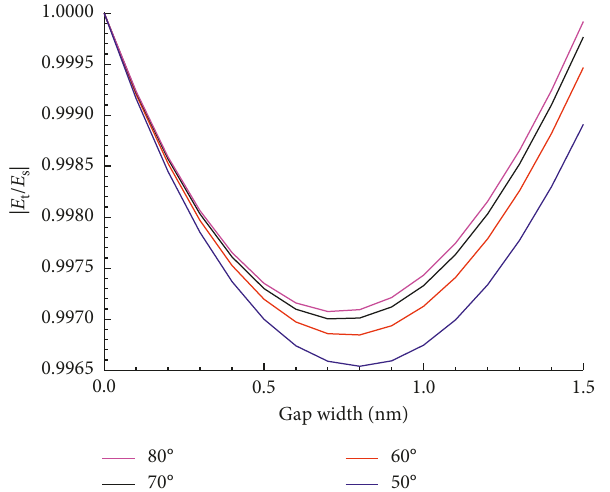
Figure 2: The influence of the angle of incidence on the ratio of fields at the tip apex and at the contacting